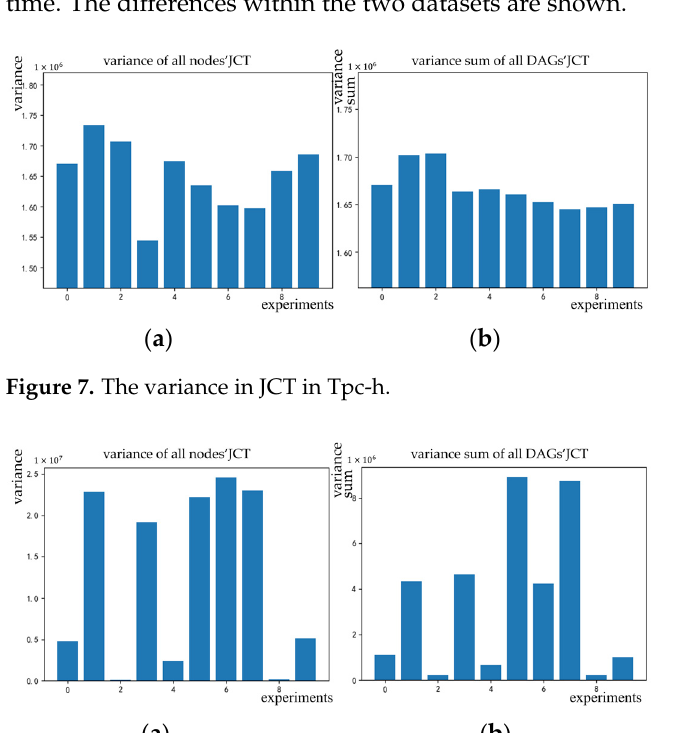
( c ) Figure 6. JCT on alidata ( a ), scientific workflows ( b ), and Tpc-h ( c ) using the proposed model, Decima, and Graphene The reason why the proposed model works well on alidata is due to it being from a real cluster scheduling trace. Its tasks have stronger diversity and a larger number. Diversity helps the model capture task features more comprehensively. The large number benefits more trial and error of the model and enhances generalization. In contrast, Tpc-h only has 154 pieces of data, and the number of DAG nodes generally ranges from 2 to 18. It is from 2 to 100 in alidata. When good results are achieved on alidata, the model has been “overfitted” on Tpc-h. This paper argues that this is the reason why APER performs worse on Tpc-h.